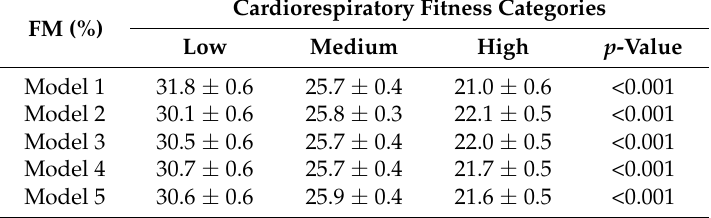
Table 3. ANCOVA models comparing fat mass percentage by cardiorespiratory fitness categories in children.